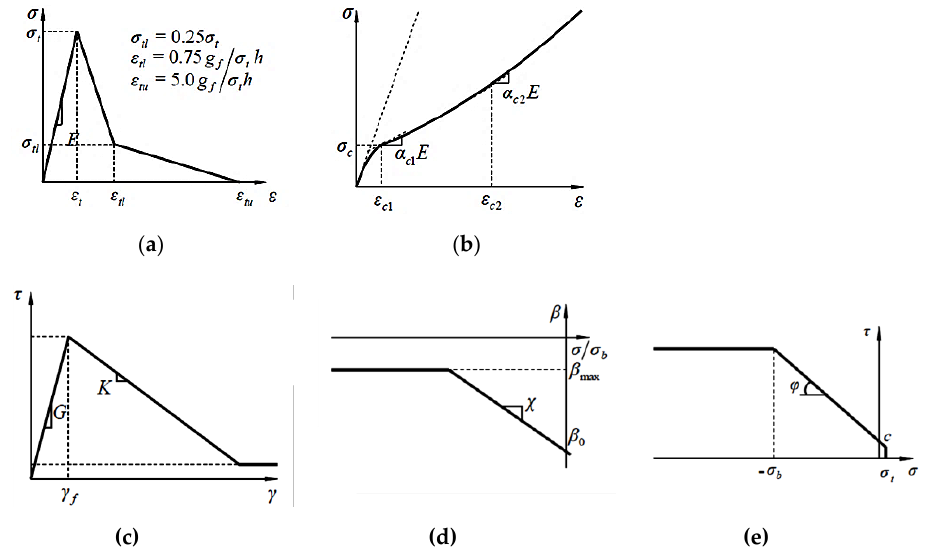
Figure 3. The constitutive models of normal and shear springs for concrete in 3D-RBSM: ( a ) Tension model for normal spring; ( b ) Compression model for normal spring; ( c ) Model for shear spring; ( d ) Softening coefficient for shear spring; ( e ) Mohr–Coulumb criterion for shear spring.